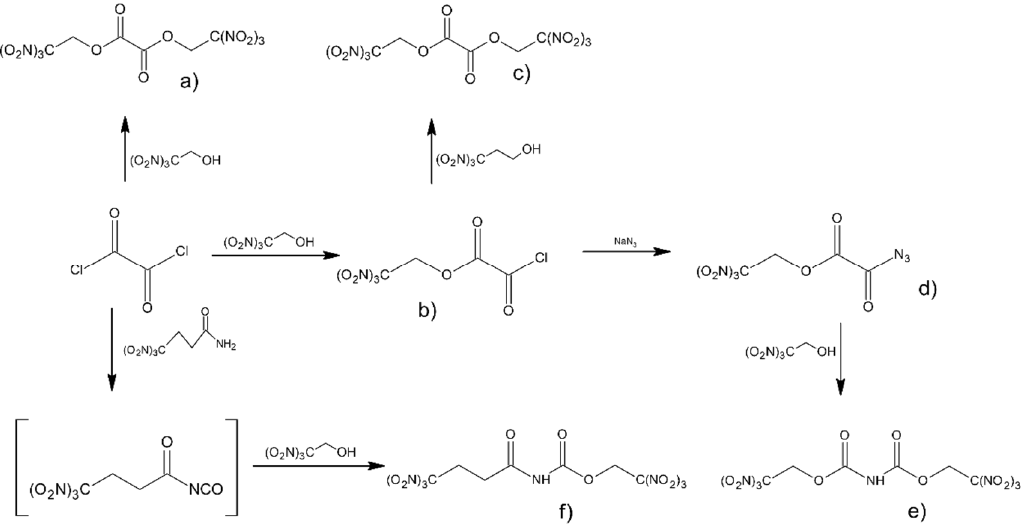
Figure 6. Synthesis of the polynitro compounds.